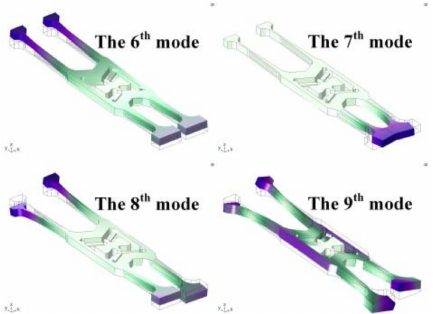
Figure 10. The 6th to 9th modal shapes of tuning forks resonant gyroscope.